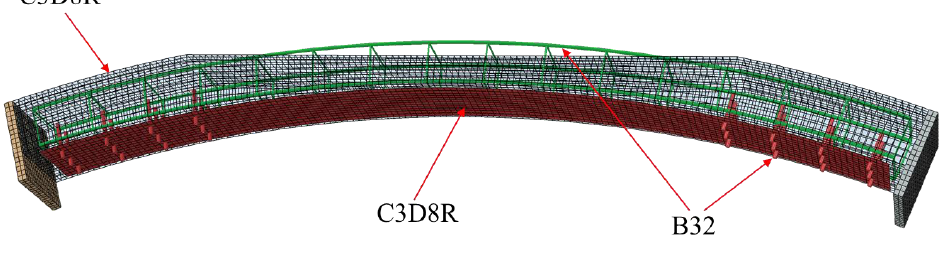
Figure 13. Grid Figure 13. Grid diagram.